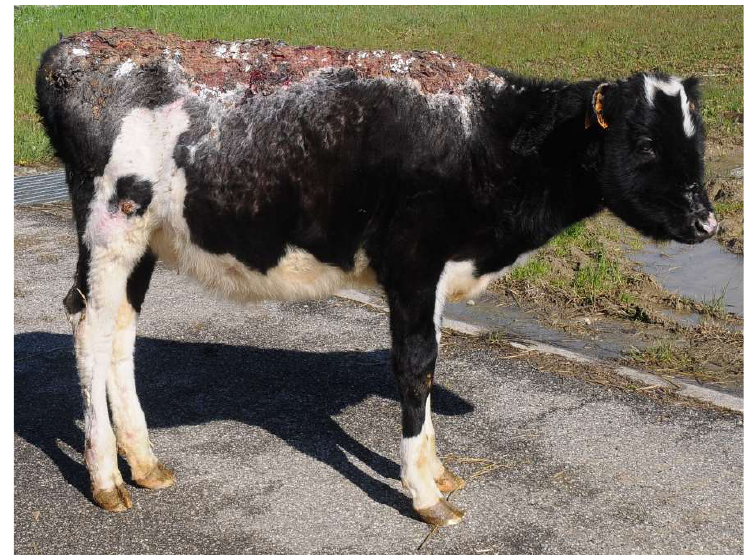
Figure 5. Heifer 2 three months after admission.